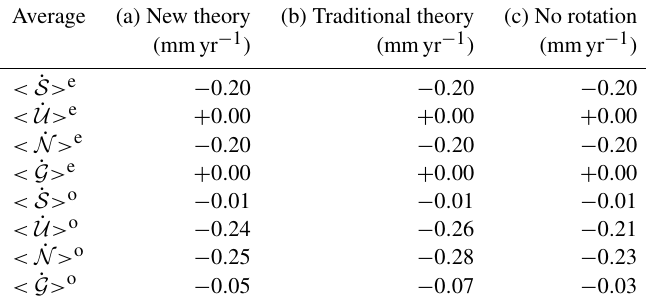
Table 4. Whole Earth and ocean averages of the GIA fingerprints according to the test run based upon the new rotation theory (column a), and the traditional theory (column b). In column (c), we also consider the case when no rotational effects are taken into account. In all the computations, we have adopted the combination R44/L128/I3 . Note that < ˙ N > e = ˙ c , where c is the FC76 constant. In this table, the SELEN 4 outputs are rounded to two significant figures.